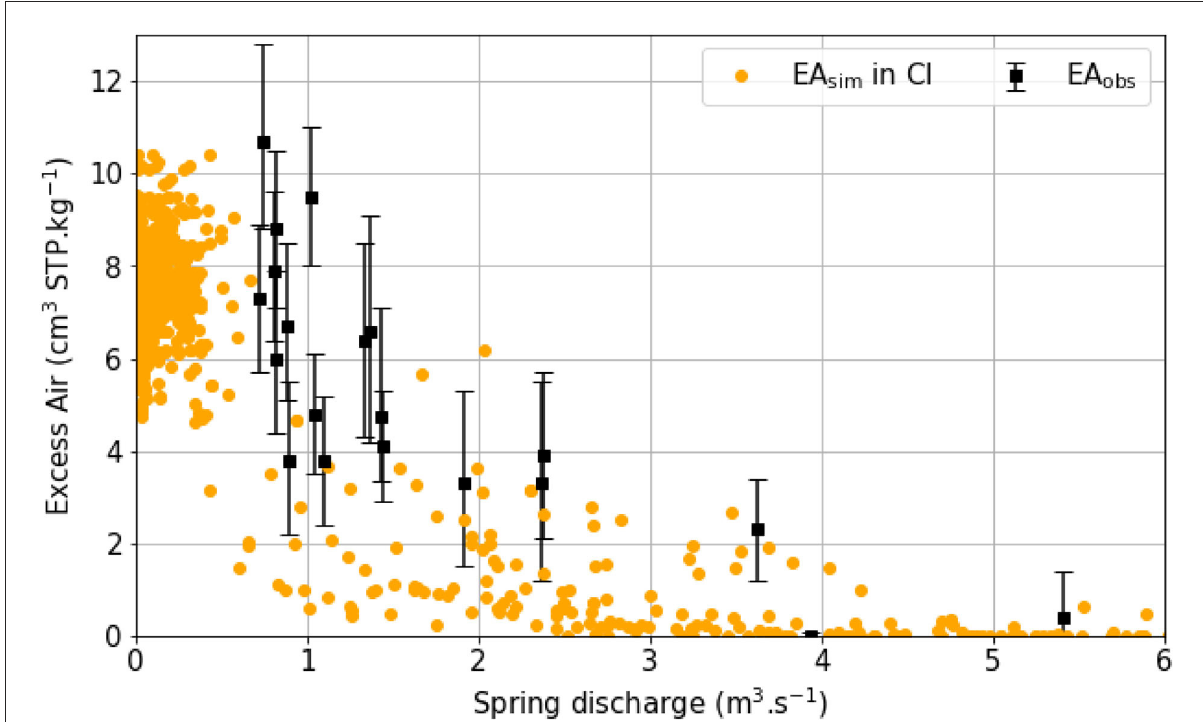
FIGURE4 Evolution of the EA signature at the Durzon spring as a function of the spring discharge. EA obs correspond to the EA measurements at the Durzon spring and EA sim is in the confidence interval (CI) with the 0.1% proportion out of 50,000 simulations within the parameter space sampled with the Latin Hypercube Sampling (LHS) procedure.